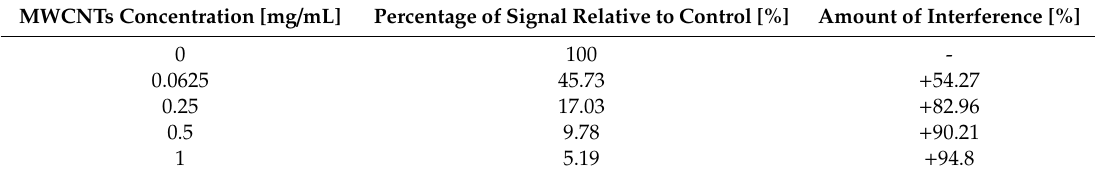
Table 2. Table showing the amount of MWCNTs interference with the luminescent signal generated by the ROS assay, with a fixed amount of H 2 O